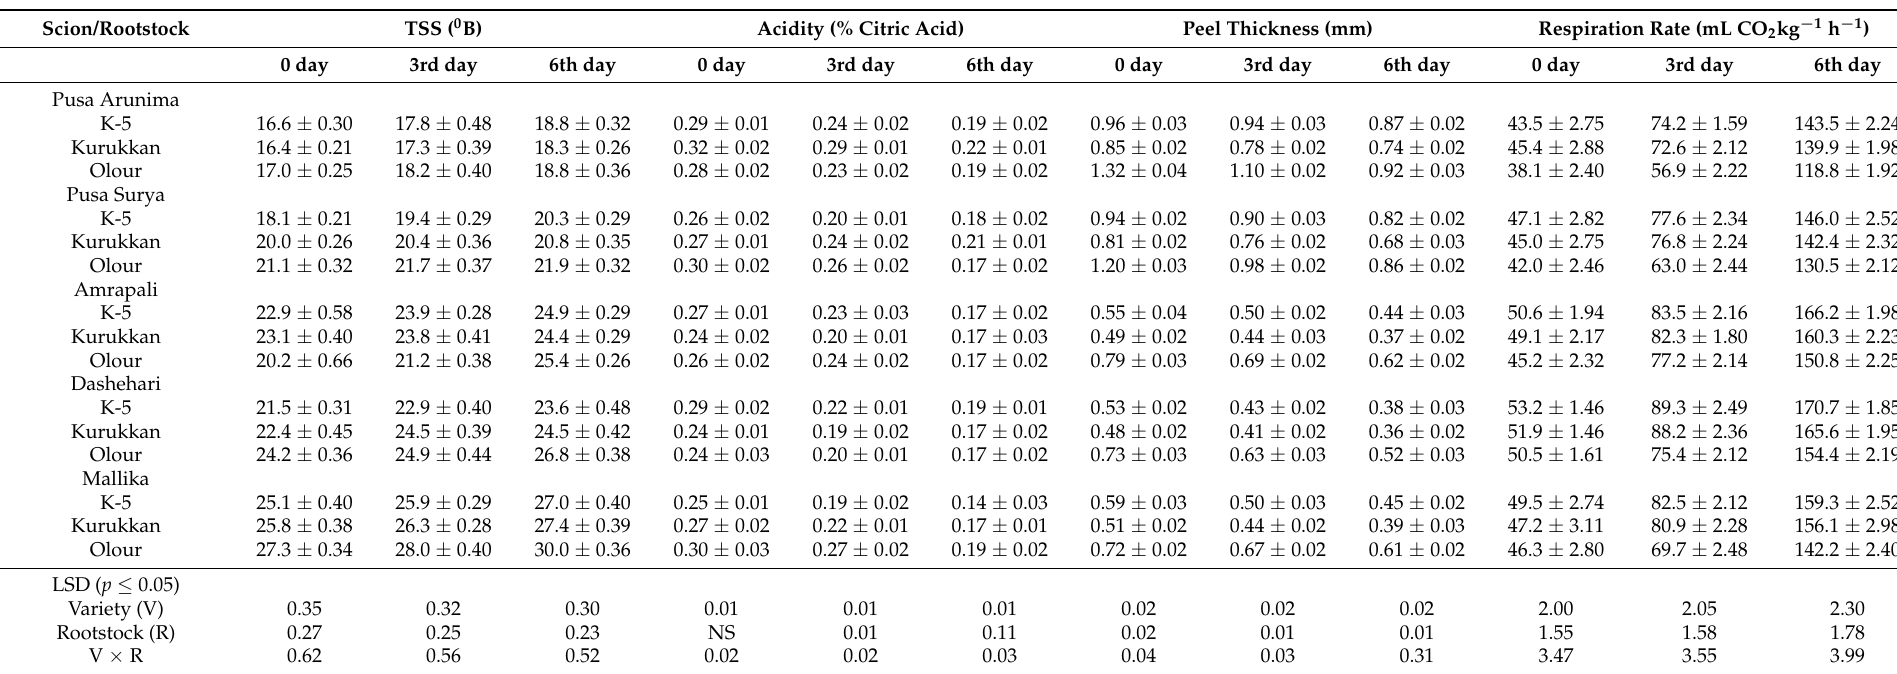
Table 3. TSS, acidity, peel thickness, and respiration rate of different mango varieties grafted on polyembryonic rootstocks during storage.